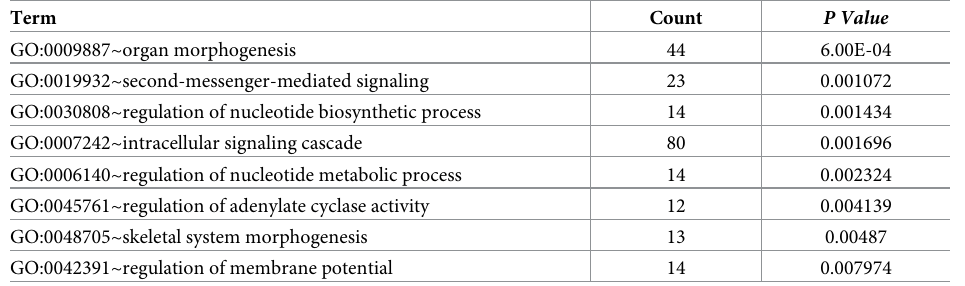
Table 4. GO enrichment using down-regulated